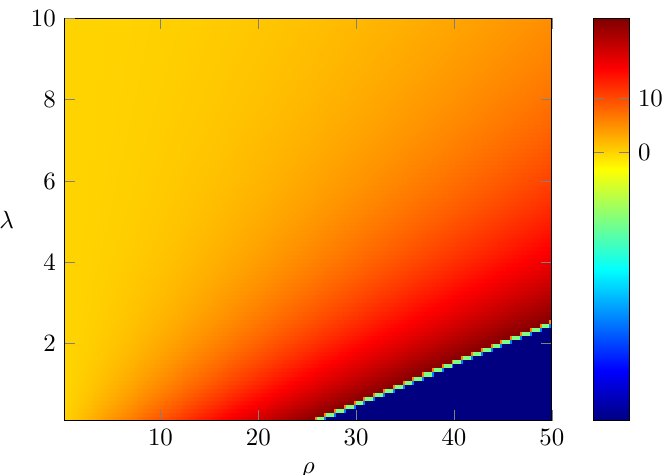
Figure 3. This shows C ∗ as a function of ρ and λ . In the darker region in the bottom right corner of the plot, this is where ruin probability is always 1 regardless of the investment. In the rest of the plot, the minimized ruin probability is less than 1. Here, we take ν = 0.1, γ = 0.5 and δ =